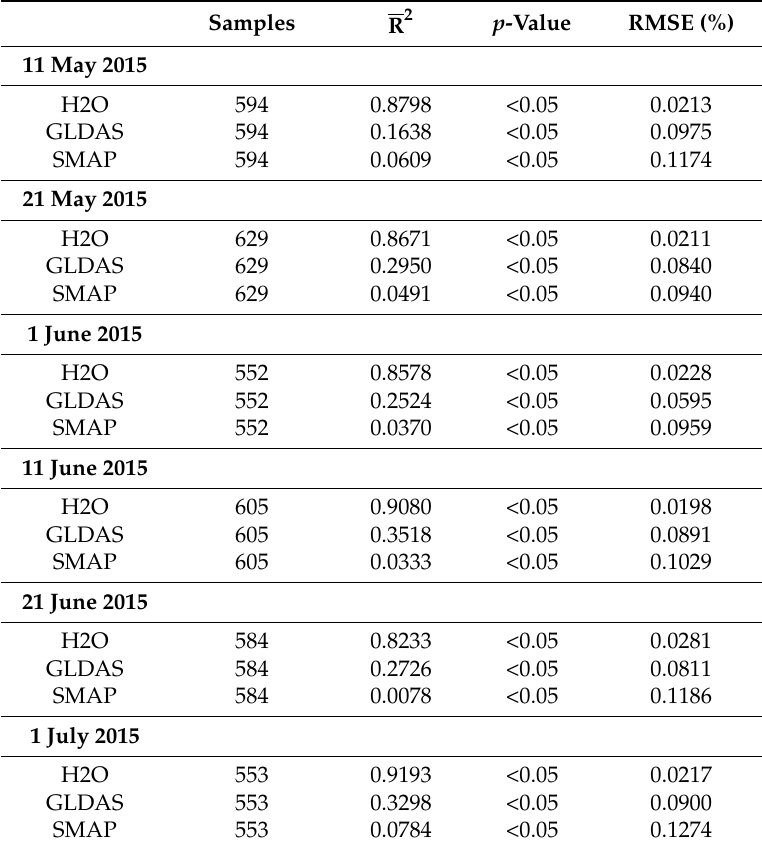
Table 5. Comparison of the performance of three types of soil moisture estimates. Samples R 2 p